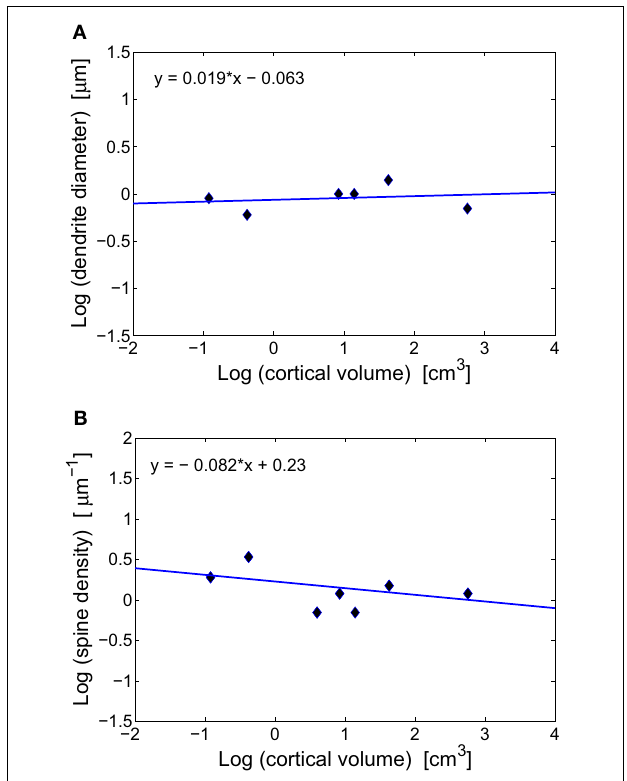
FIGURE 2 | Scaling of dendritic characteristics of pyramidal cells with cortical volume. (A) Conservation of basal dendrite diameter across species. The log–log fit gives a scaling exponent around zero ( y = 0 . 019 x − 0 . 063), with non-significant weak correlations ( r = 0 . 202, p = 0 . 702). (B) Conservation of spine density on a dendrite across mammals. The log–log fit gives a scaling with a small non-significant exponent ( y = − 0 . 082 x + 0 . 23, r = − 0 . 477, p = 0 .